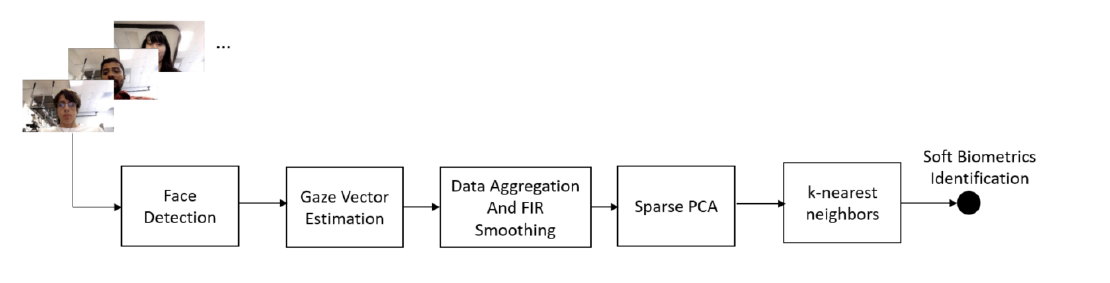
Figure 1. A block diagram representation of the proposed